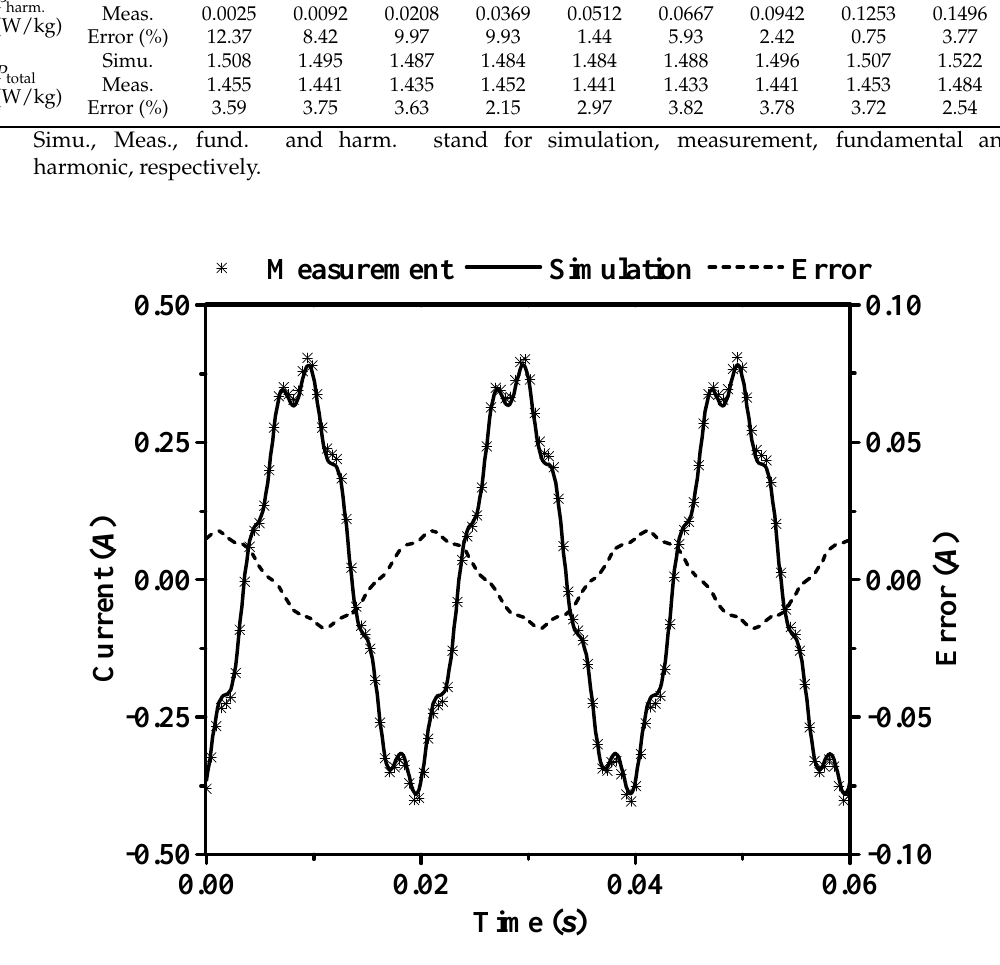
Figure 8. Comparison of the simulation and measurement results of the exciting current with 7th harmonic injections ( B peak = 1.0 T, 35%